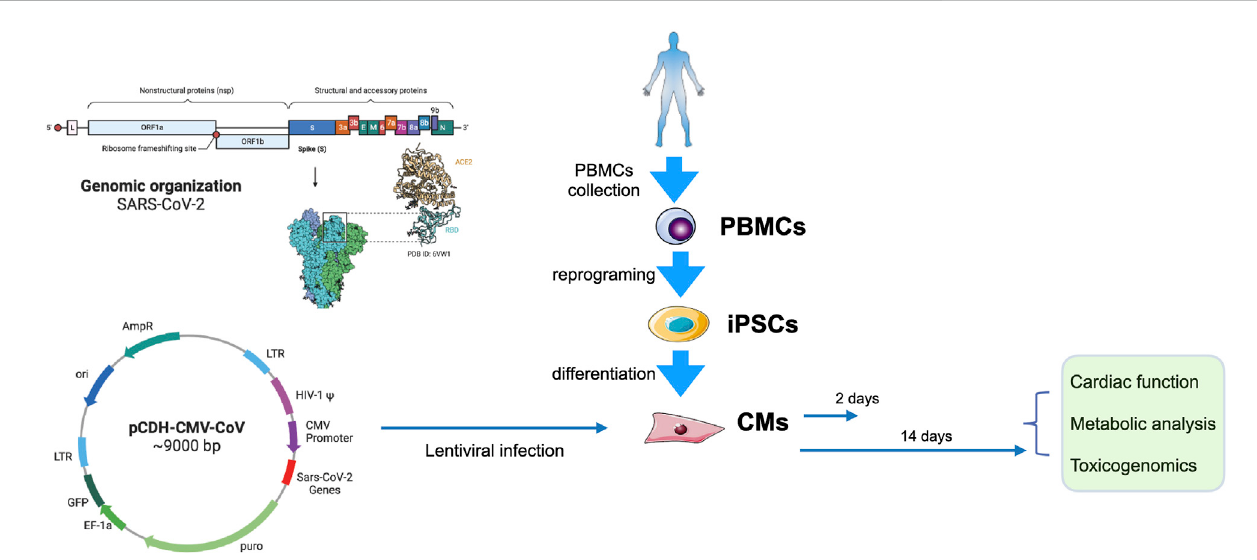
Experimental design. Left, the genomic organization of SARS-CoV-2 (up) and the map of pCDH-CMV-CoV (down). Right, PBMCs from a health donor were collected and reprogrammed into iPSCs, and then were differentiated into CMs. The CMs were transduced with lentivirus carrying SARS-CoV-2 genes on day 30. Cells we collected for functional, metabolic, and toxicogenomic analyses 2 days (day 32) or 2 weeks (day 45) after